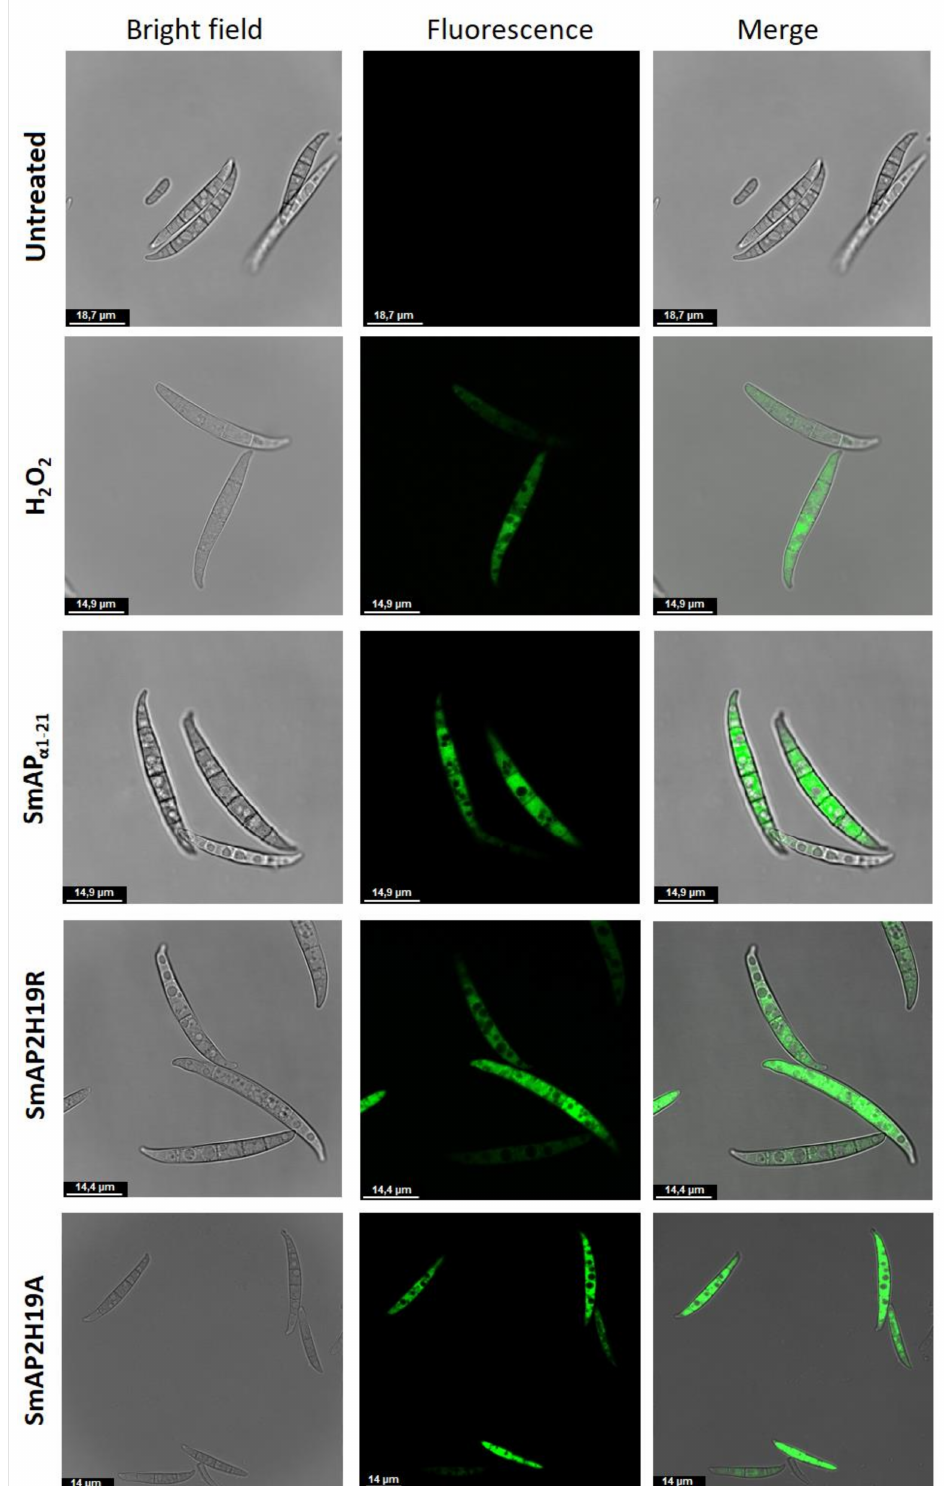
Figure 7. Representative confocal fluorescence images showing production of reactive oxygen species (ROS) by Fusarium graminearum in response to treatment with peptides SmAP α 1-21 , SmAP2H19R, and SmAP2H19A at their MIC for 1.5 h. Bright-field, fluorescence, and merged images are shown as different columns. H 2 DCFDA probe was used at 10 µ M ( λ ex 492 nm and λ em 527 nm). Bar indicates size in µ